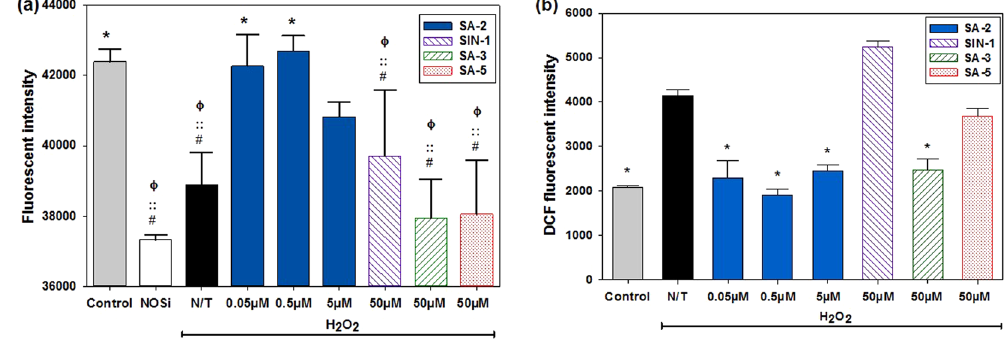
Figure 2. Effects of SA-2 on Nitric Oxide Synthase (NOS) activities ( a ) and scavenging of ROS ( b ) in HUVECs. The cells were seeded and after being confluent in tissue culture plates, they were co-treated with H 2 O 2 and either SA-2 at different concentrations, a reference NO donor SIN-1 (50 µ M), a reference antioxidant SA-3 (50 µ M) or a reference hybrid compound SA-5 (50 µ M). Control samples were cells without exposure to H 2 O 2 and any reagent, whereas N/T samples were cells exposed to H 2 O 2 only. NOS knock-down samples (NOSi) were cells exposed to a competitive NOS inhibitor L-NNA at 50 µ M. After 24-hour-treatment, total NOS activity (Fig. 2a) from treated cells was quantified using OxiSelect ™ Intracellular Nitric Oxide (NO) Assay Kit where NOS activity correlates to fluorescent intensity. Similarly, ROS levels (Fig. 2b) were quantified with DCFDA assays. Results were analyzed on SigmaPlot with ANOVA and post hoc Pairwise Multiple Comparisons using Holm-Sidak method. Data were shown as mean ± standard deviation. Stars ( * ), phi ( φ ), double-colon (::) and hashtag (#) indicate significant difference (P < 0.01; n = 4) with respect to N/T, control, SA-2 at 0.05 µ M and SA-2 at 0.5 µ M, respectively.